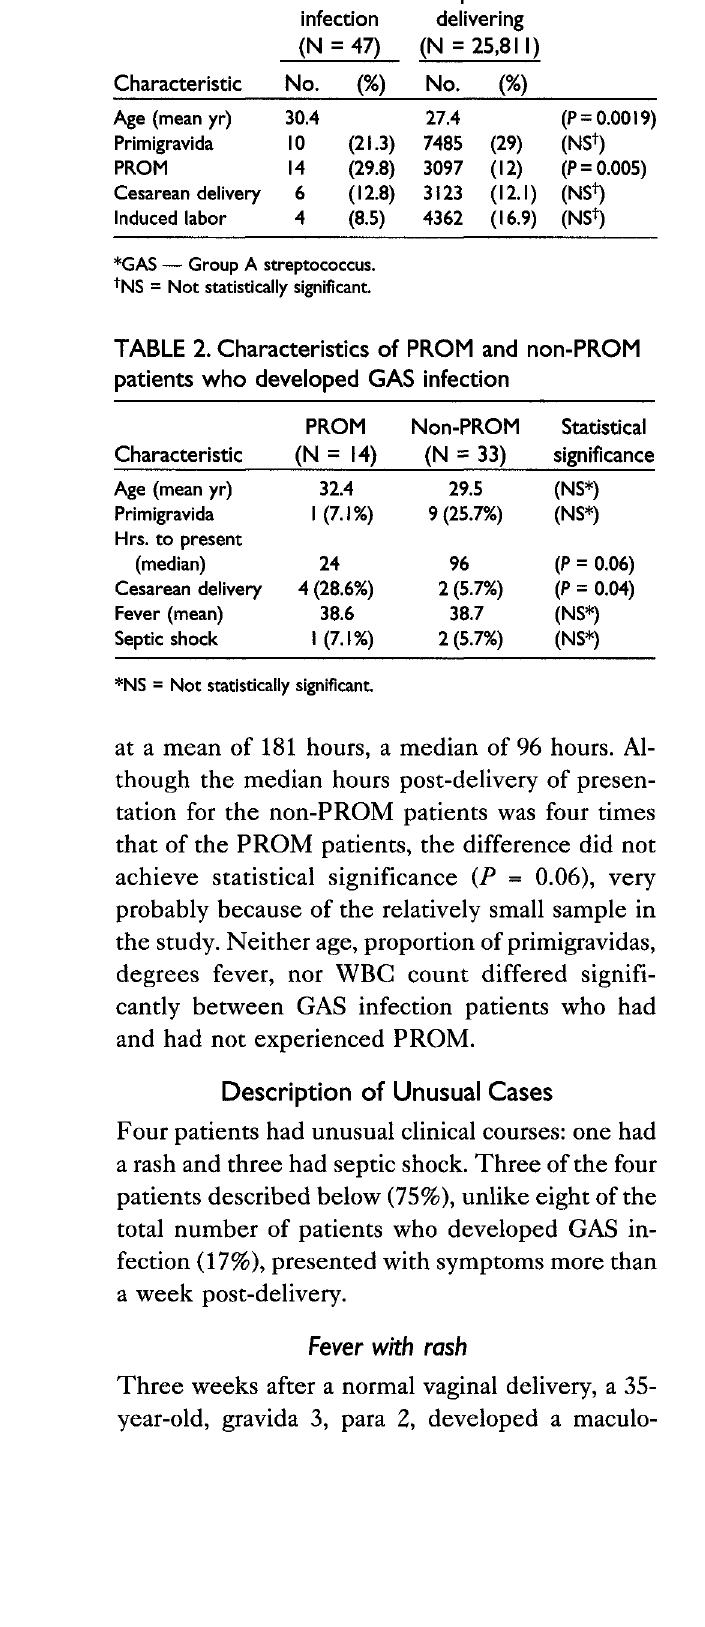
TABLE 2. Characteristics of PROM and non-PROM patients who developed GAS